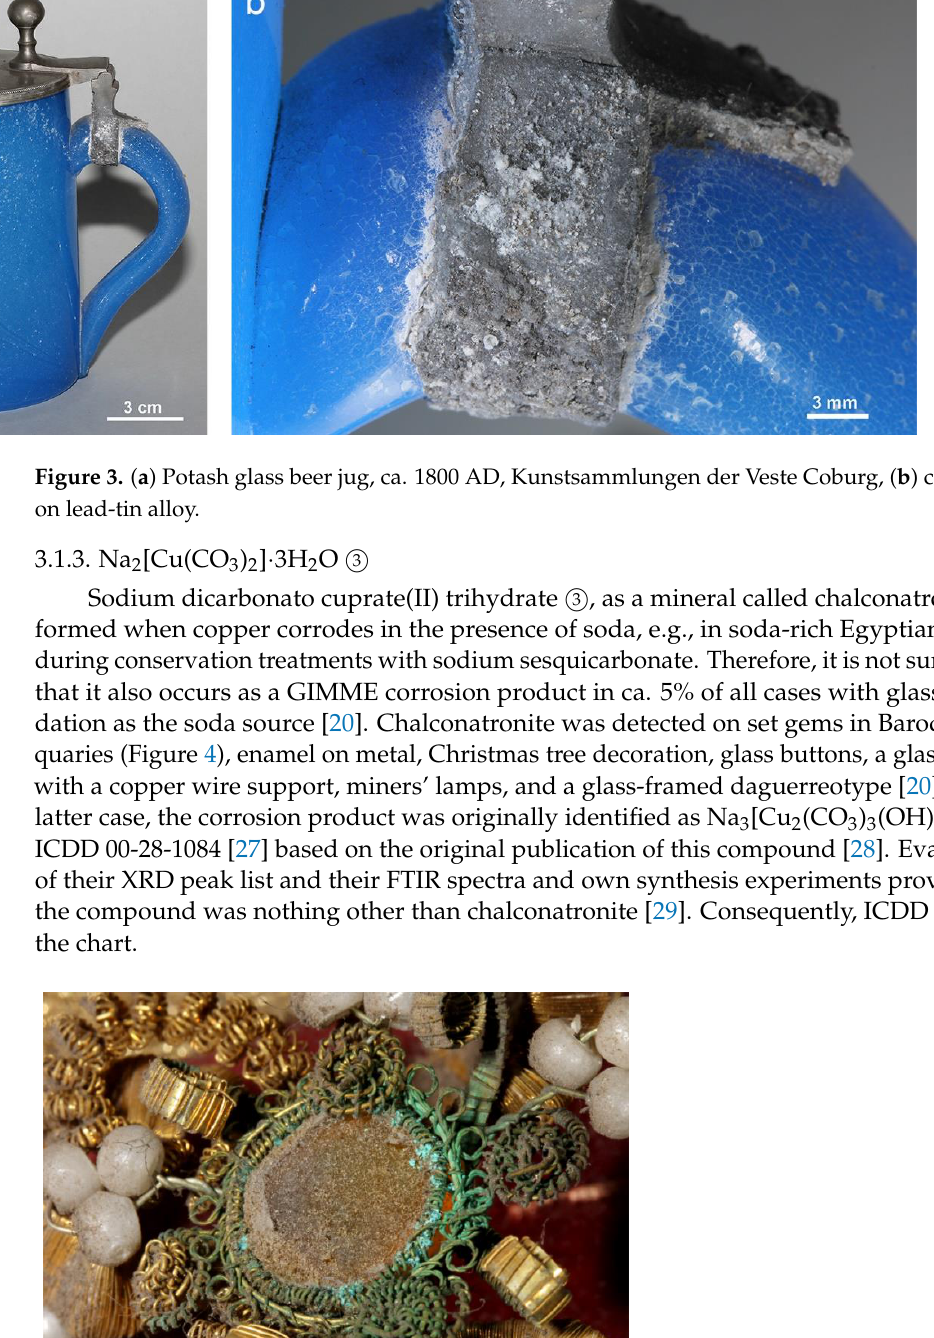
Figure 2. Broken lead coated glass sphere from a bridal crown) (Photo: Stephanie Wümmers) .